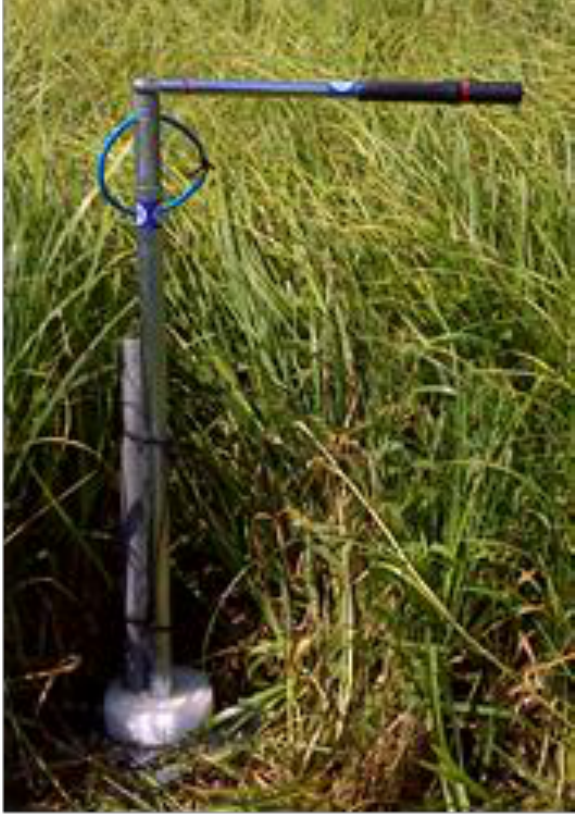
Figure 1. Using a portable spiked plate (made by PIMR) with torque wrench to test surface strength in a sward of common reed on organic muck soil, water table depth 0.5 m. Photo: PIMR